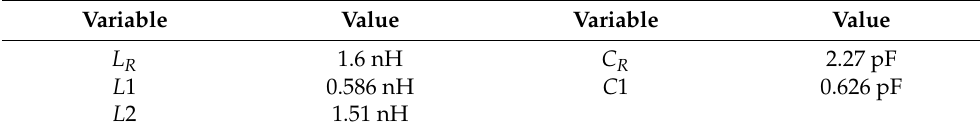
Table 3. The values of the circuit elements of the E-CRLH resonator.